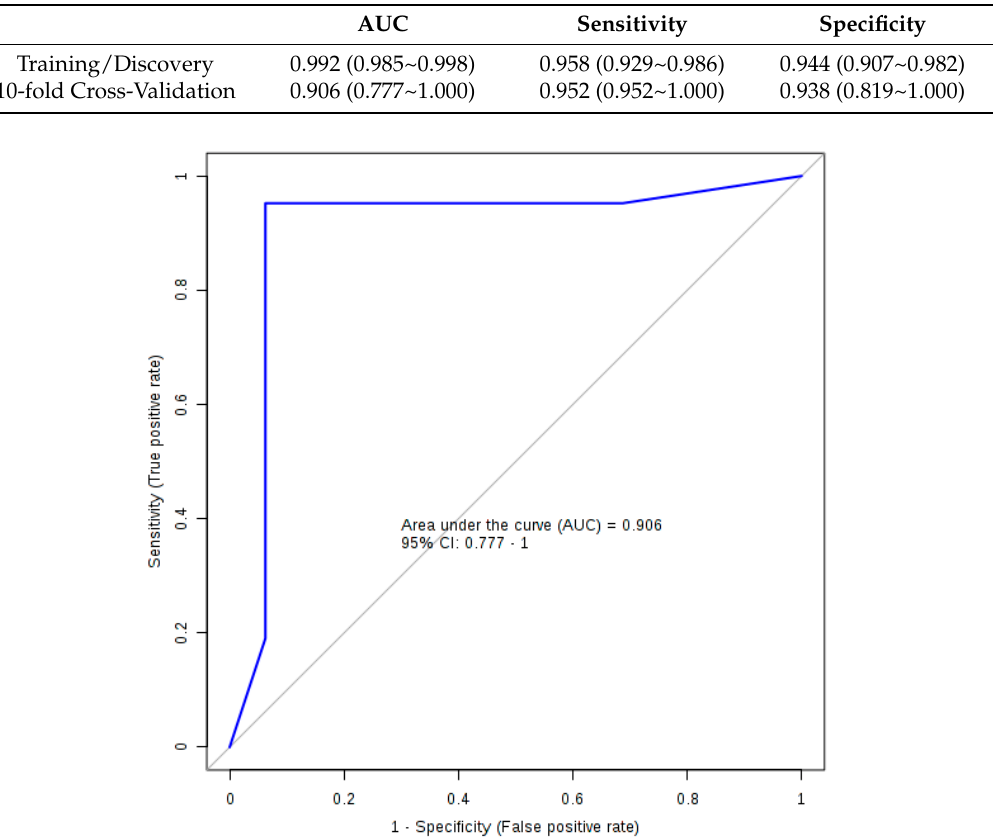
Table 3. The performance values for the logistic regression model.